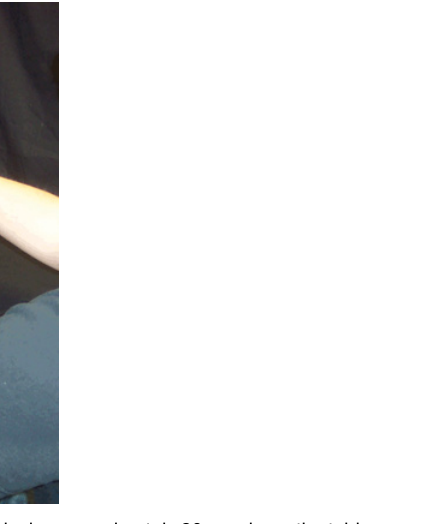
Fig 2. Blocks held by participant. Participant holding blocks approximately 20 cm above the table.